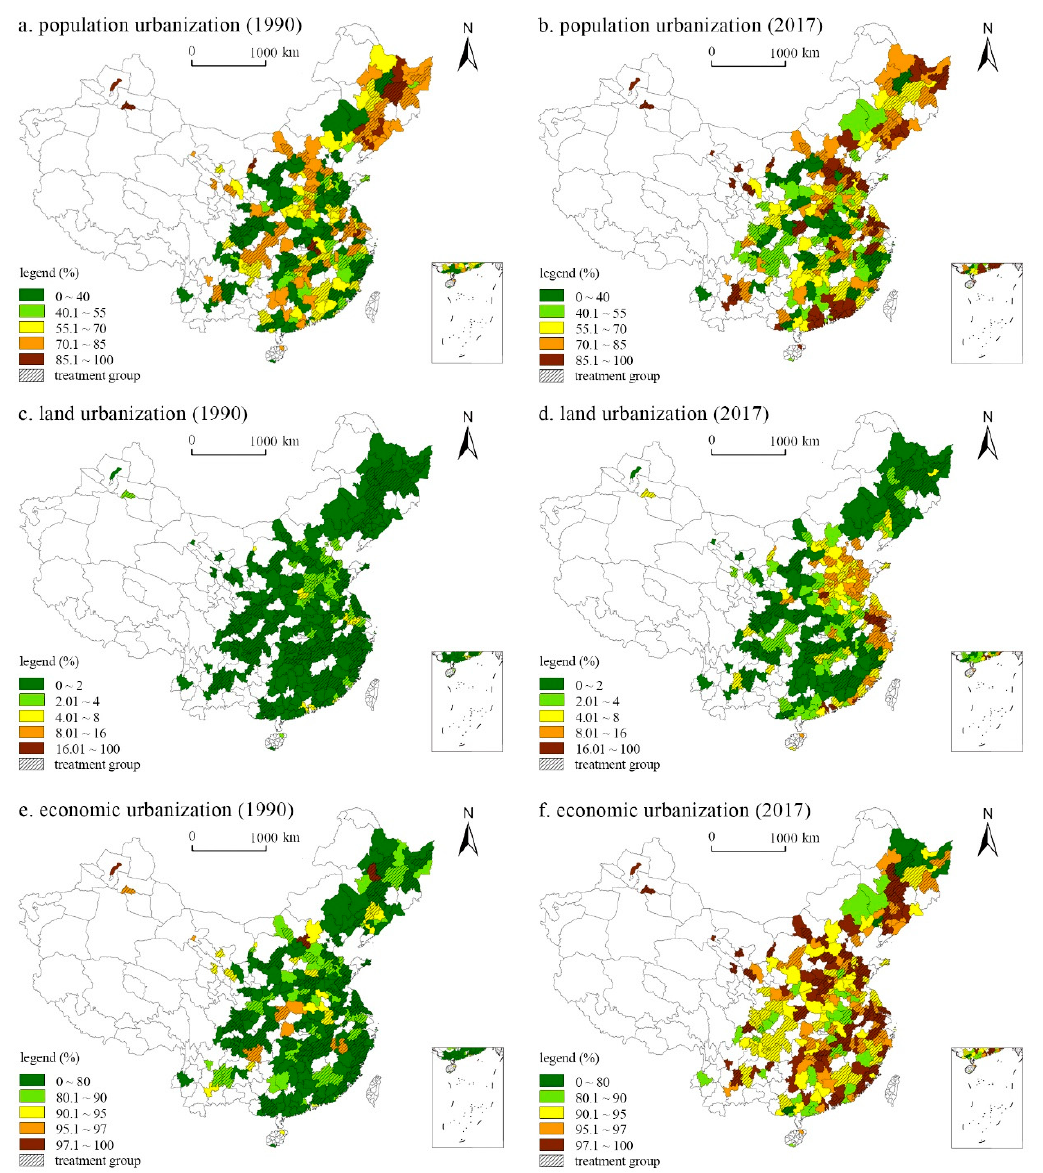
Figure 1. Urbanization spatial pattern of treatment group and control group in China.